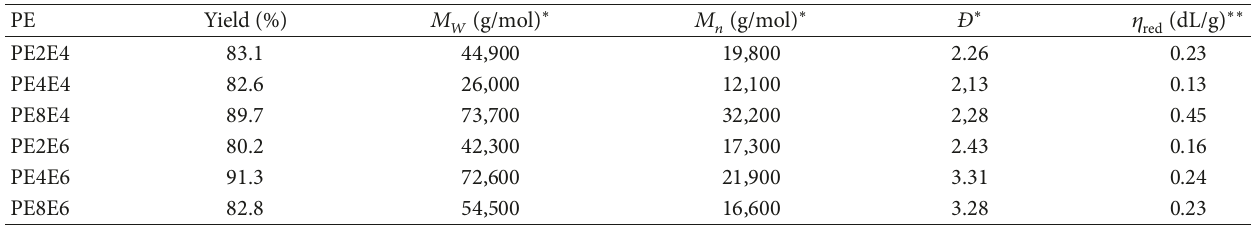
Table 11: Characteristics of the obtained click PEs.